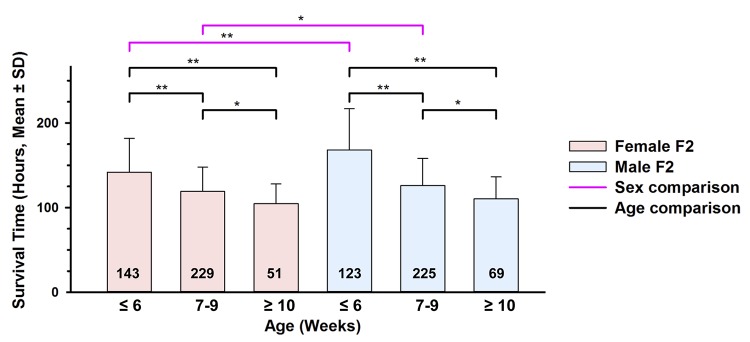
Survival time comparisons of F2 mice stratified by age and sex.Survival times for all exposed F2 mice (n = 840) generated from B and X1 progenitors, were sorted by sex into the three age groups: ≤ 6 weeks old, 7–9 weeks old, and ≥10 weeks old at the initiation of exposure. The number of F2 mice represented in each group is given at the base of each bar plot. Comparisons were made between age groups for females or males and between sexes for the same age group, and Bonferroni corrected for multiple testing. *, p < 0.05; **, p < 0.001.